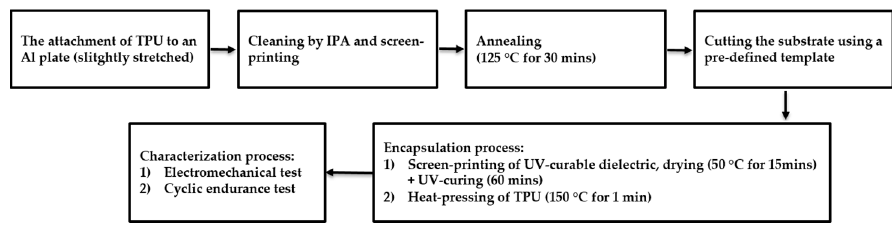
Figure 1. A summary of the fabrication and characterization of stretchable interconnects.